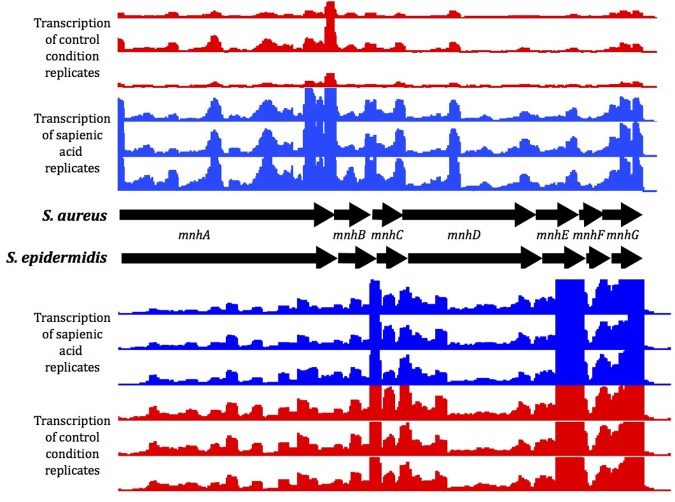
Gene expression of the mnh operon under control conditions (red) or following sapienic acid challenge (blue). Mapped reads for replicate RNA-Seq data were visualized in integrated genome browser (IGB).